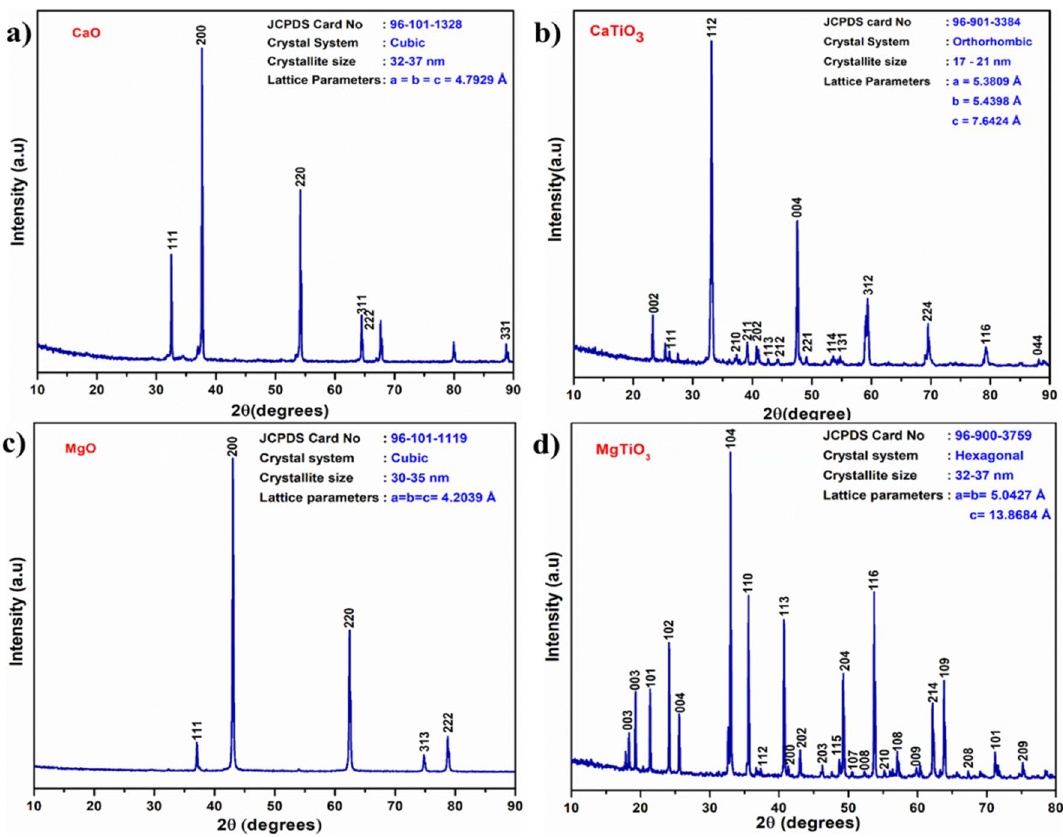
Figure 2. XRD patterns of ( a ) CaO, ( b ) CaTiO 3 , ( c ) MgO and ( d ) MgTiO 3 .